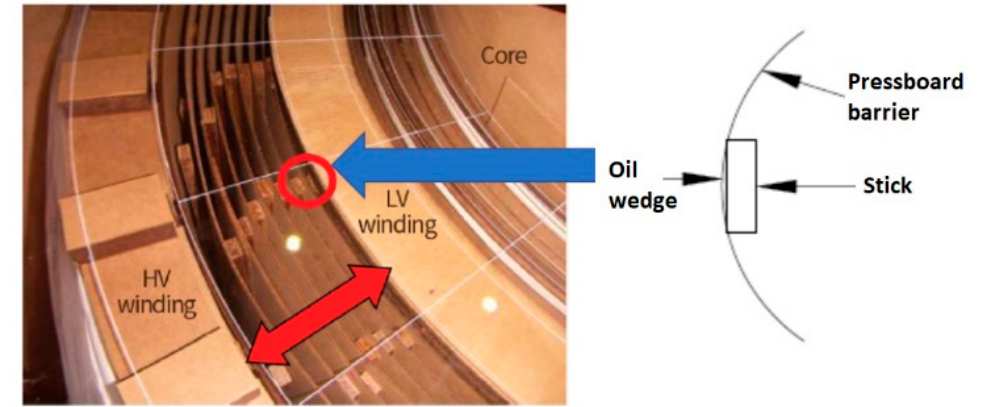
Figure 1. Example of the place of occurrence of an oil wedge in a transformer.